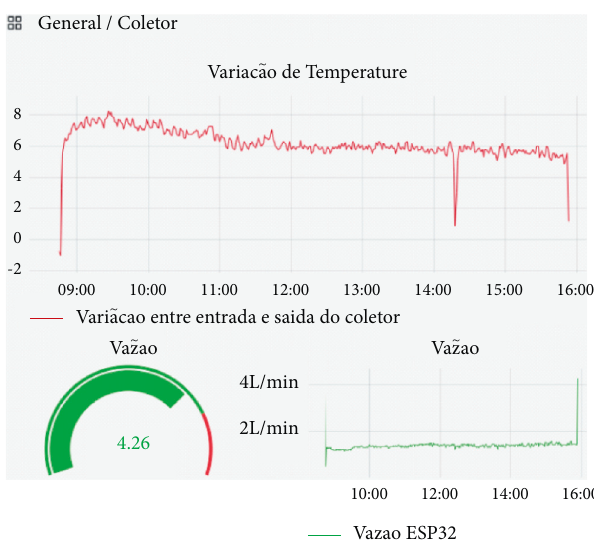
Figure 6: Screenshot of the data visualization